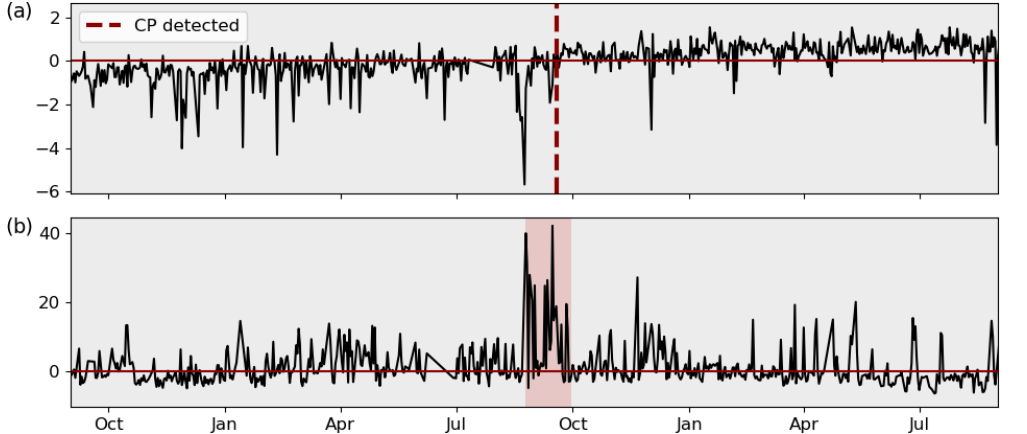
Figure 9. Examples of misclassification in gearbox (a) and generator (b) bearing temperature. Each change in background colour indicates a true CP; each dashed line indicates a detected